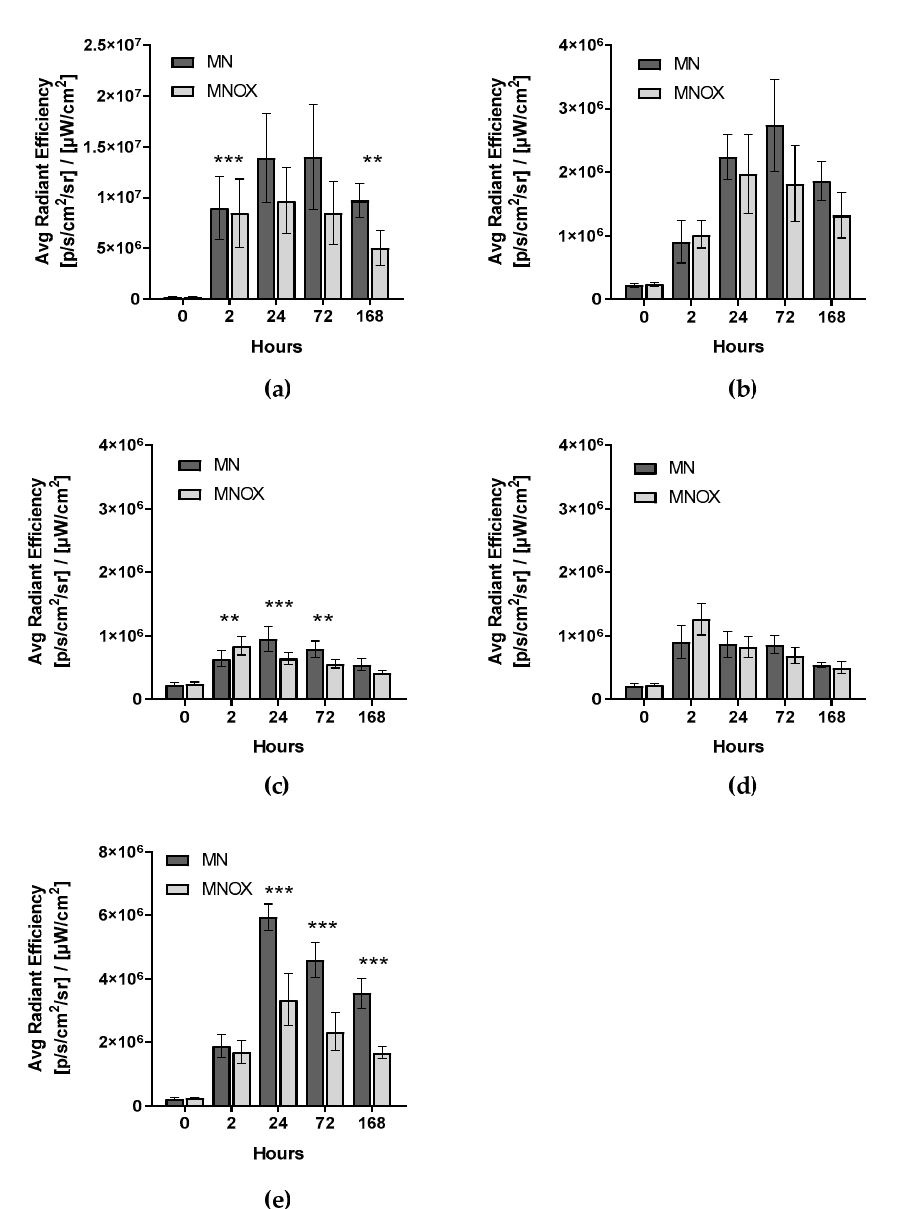
Figure 3. Quantification of fluorescence signals in different time intervals in vivo. Signals were quantified from ( a ) SLNs (inguinal lymph nodes on tumor site), ( b ) axillary lymph nodes on tumor sites, ( c ) axillary lymph nodes on non-tumor sites, ( d ) inguinal lymph nodes on non-tumor sites and ( e ) livers. The multiple one-tailed t-test was used for statistical evaluation (n = 9 for MN and n = 9 for MNOX). The fluorescent signal is represented as the average radiant efficiency (mean ± SD), p -values: *** p < 0.001, ** p < 0.01, * p < 0.05.